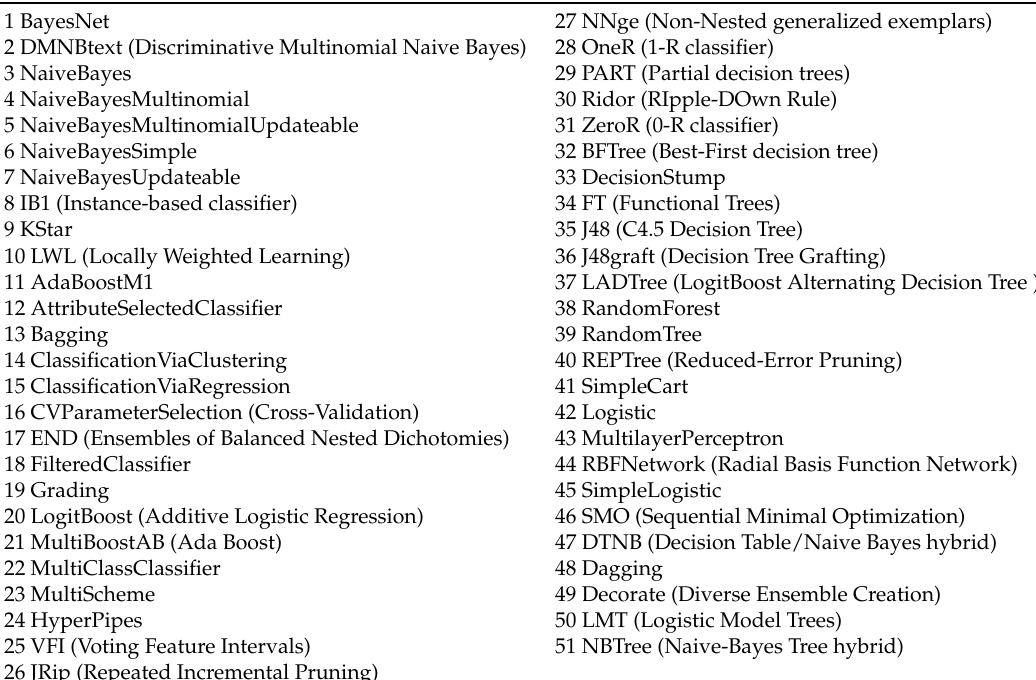
Table 2. Subset of classification algorithms { a 1 } ⊆ A